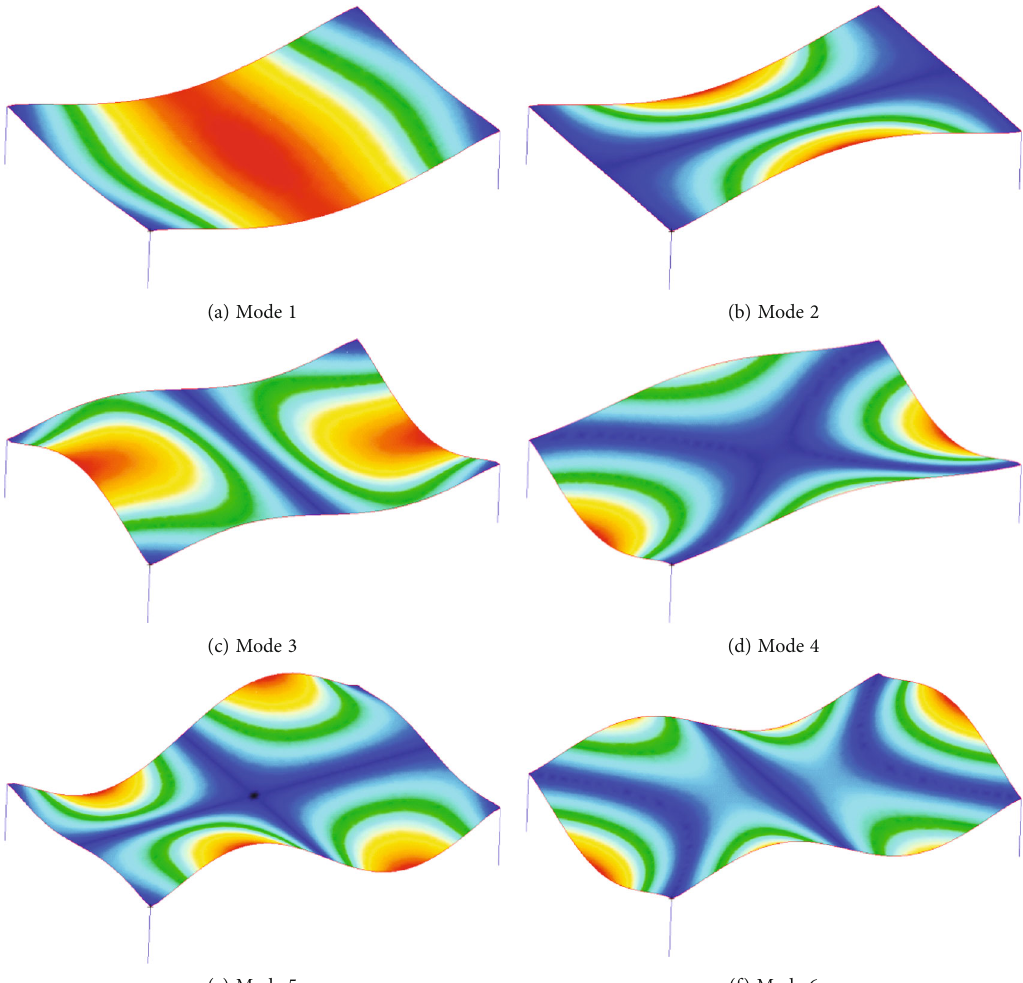
Figure 6: Mode shapes of fi rst six